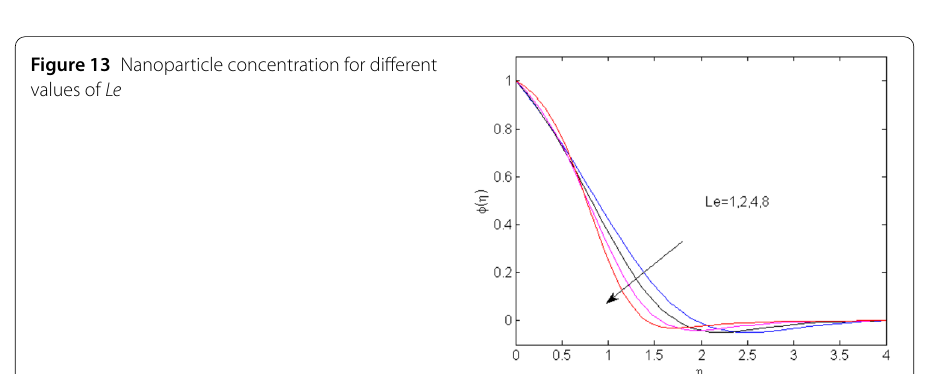
Figure 13 Nanoparticle concentration for different values of